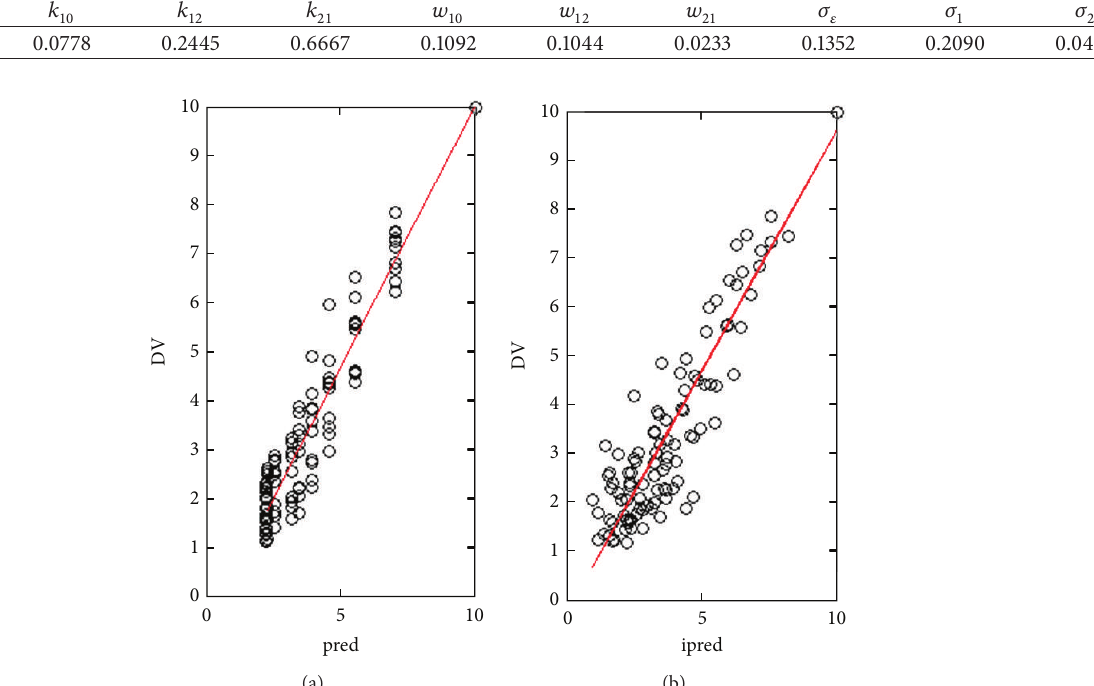
Table 2: The parameters estimators of C-peptide concentrations.